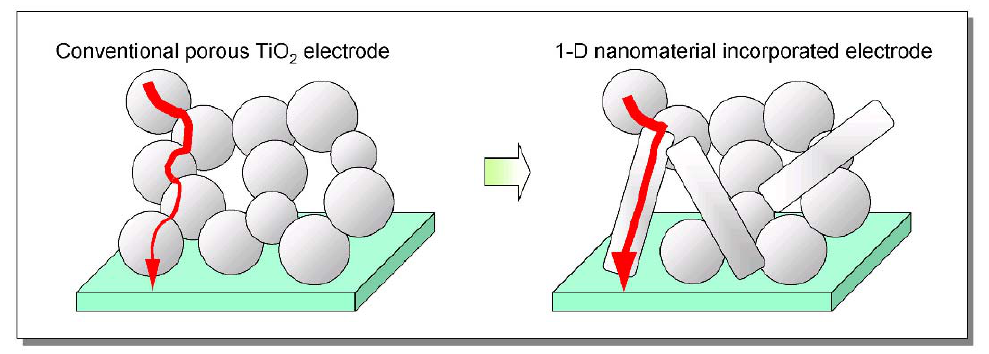
Fig. 1 ”Electron expressway concept” by the incorporation of 1-D nanomaterials for DSC electrode. The arrows indicate the path of the electron